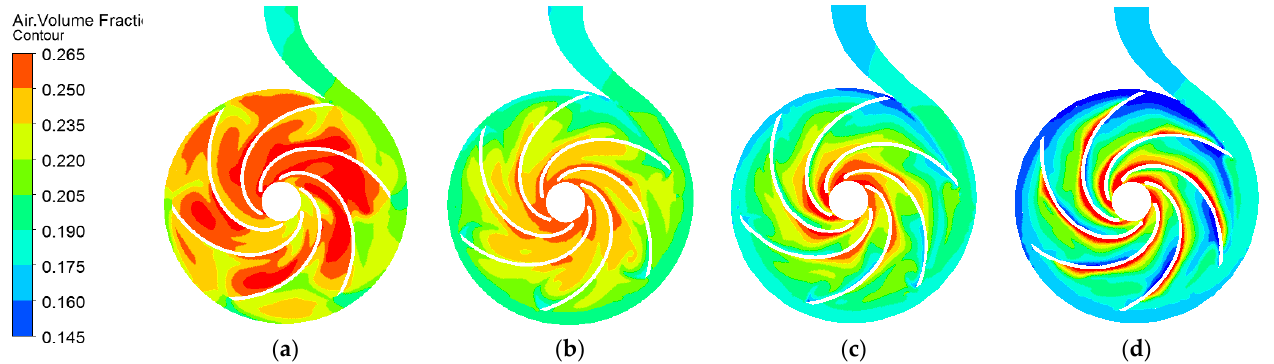
Figure 9. Gas volume fraction distribution of axial vertical plane at α g = 0.15. ( a ) t = 1 s; ( b ) t = 2 s; ( c ) t = 3 s; ( d ) t = 4 s.